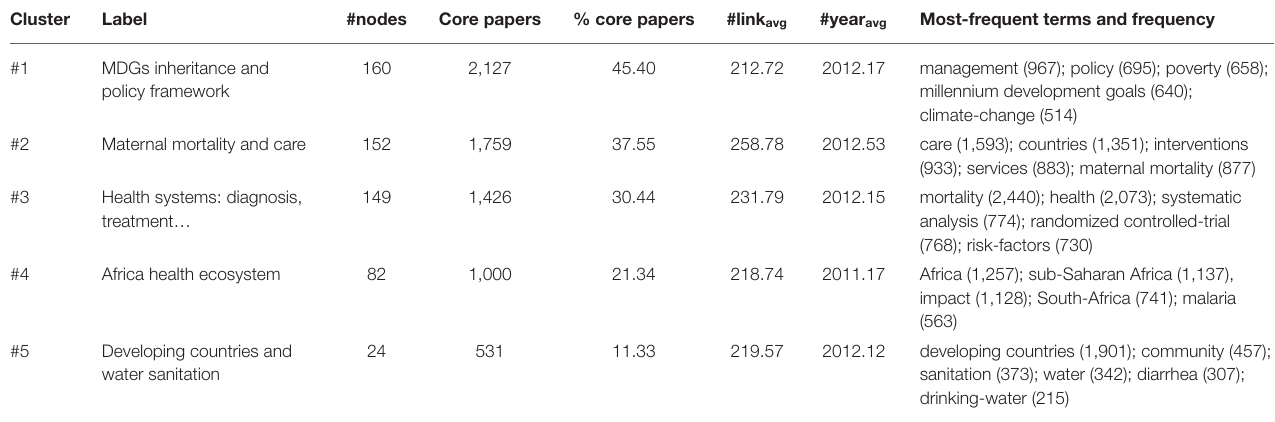
TABLE 2 | Summary of five thematic